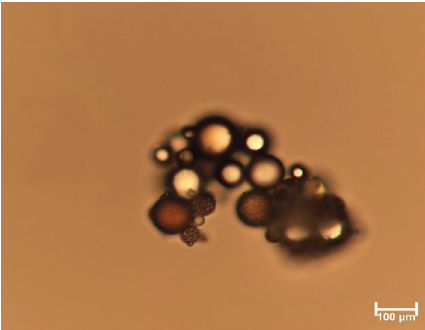
Figure 3: Microscope image of submillimeter-scale SMG morphology. The shape of SMG is regular sphericity, and the initial median particle size is 11.39 μ m.